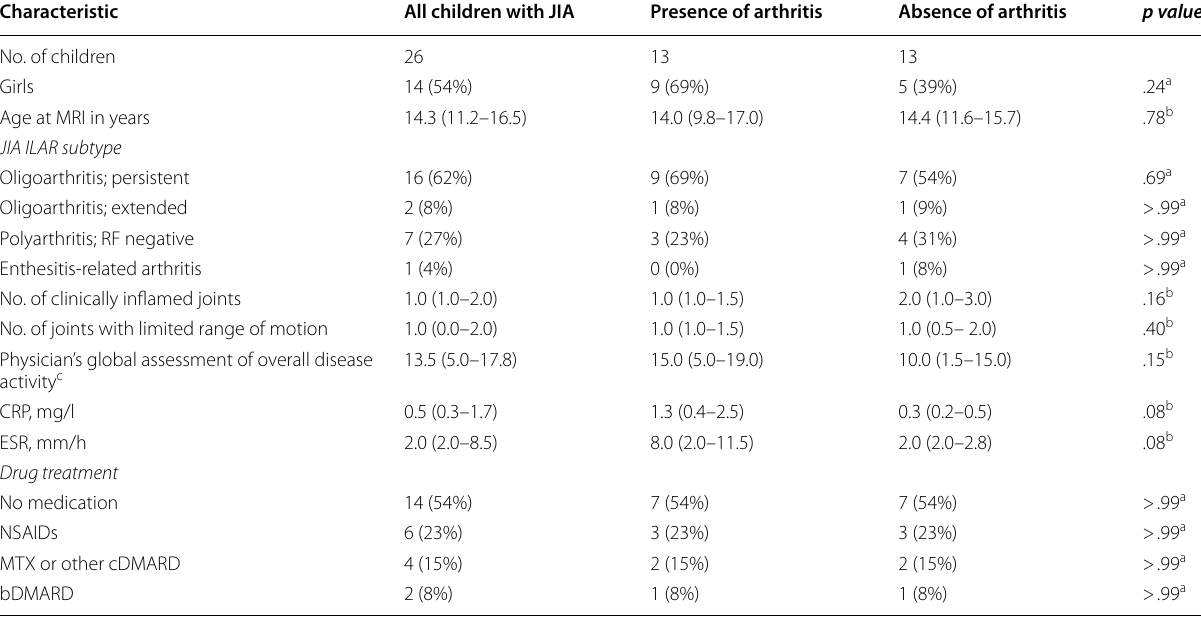
Data are displayed as numbers (frequencies) or median (interquartile range), unless otherwise stated JIA, juvenile idiopathic arthritis; ILAR, International League of Associations for Rheumatology; RF, rheumatoid factor; CRP, C-reactive protein; ESR, erythrocyte sedimentation rate; CE, contrast-enhanced; NSAIDS, nonsteroidal anti-inflammatory drug; MTX, methotrexate; cDMARD, conventional disease-modifying antirheumatic drug; bDMARD, biologic disease-modifying antirheumatic drug a Fisher’s exact test b Mann–Whitney U test c Visual analogue scale: 0 mm best, 100 mm = =